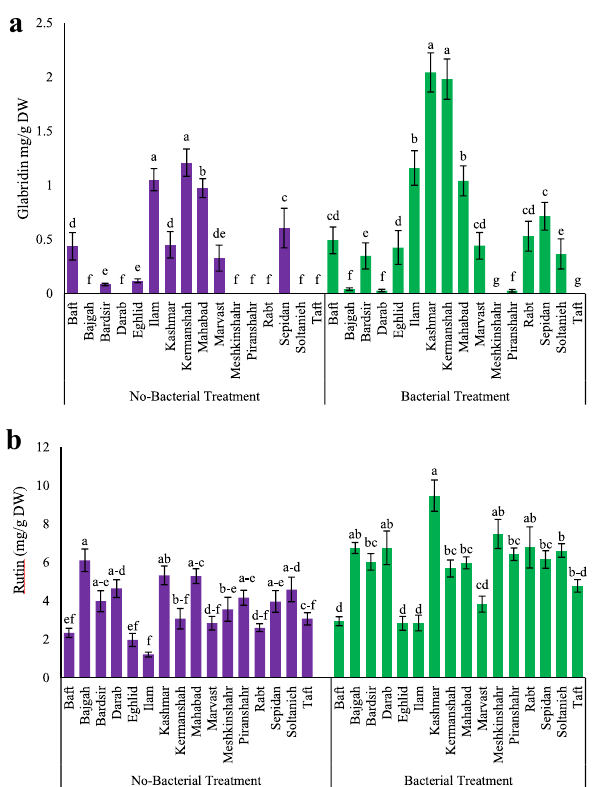
Figure 4. Measured parameters variation under studied treatments. ( a) Glabridin, ( b) Rutin. According to the analysis of variance, only multiple effects of Azotobacter and accessions showed a significant difference, just its mean comparison is shown. Mean values with the same letters are not significantly different ( p ≤ 0.05), Tukey test. Bars stand for standard error